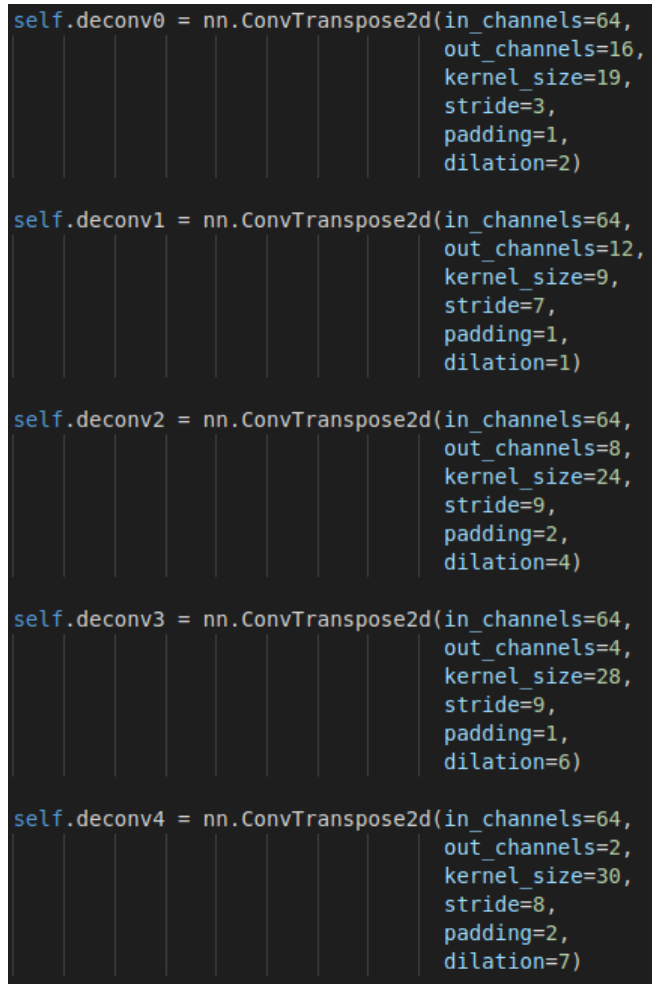
Figure A5. Deconvolution layers. Source: https://github.com/Keredu/Intracranial-Hemorrhage- Detection/blob/main/src/model.py, accessed on 16 November 2022.